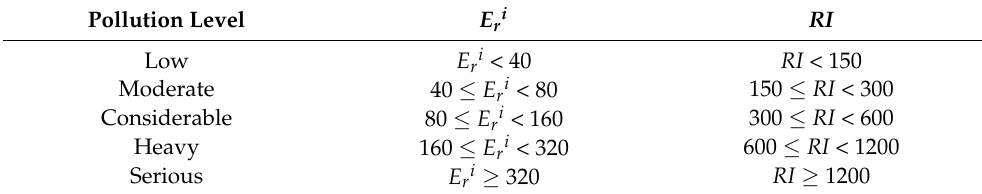
Table 4. Potential risk index classification of the degree of